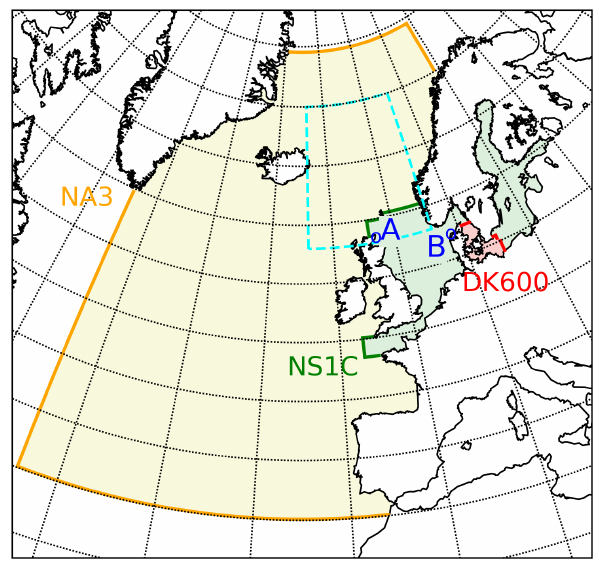
Figure 5. FCOO nested GETM ocean model setup: NA3, NS1C, and DK600. Station Wick (A) is used as proxy for effect on bound- ary conditions for the NS1C model, while station Hanstholm (B) is used to gauge the actual effect on the NS1C model. For later refer- ence the north-east Atlantic area “neatl” (latitudes 58 to 70, longi- tudes − 14 to 6) is marked with a dashed cyan